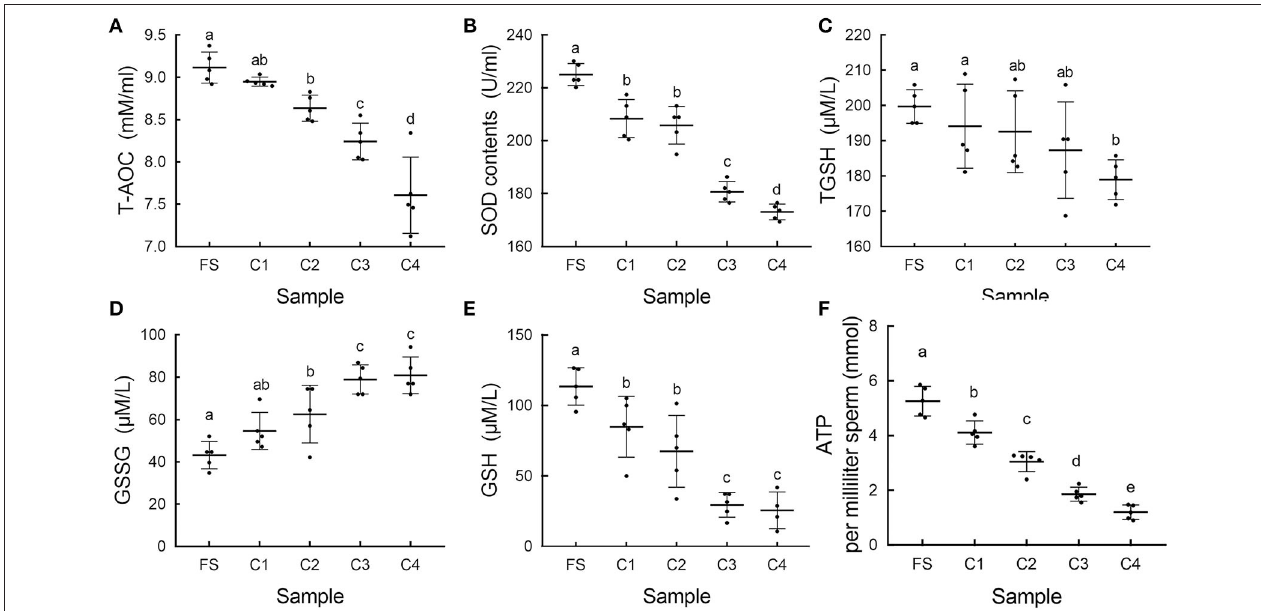
FIGURE 6 | The change of oxidation resistance during cold storage. (A) The changes of total antioxidant capacity (T-AOC) in sperm during storage in vitro . (B) The changes of superoxide dismutase (SOD) in sperm. (C) The changes of total glutathione (TGSH) in sperm. (D) The changes of oxidized glutathione disulfide (GSSG) in sperm. (E) The changes of reduced glutathione (GSH) in sperm. (F) The changes of adenosine triphosphate (ATP) contents in sperm. Different letters indicated significant difference ( p <